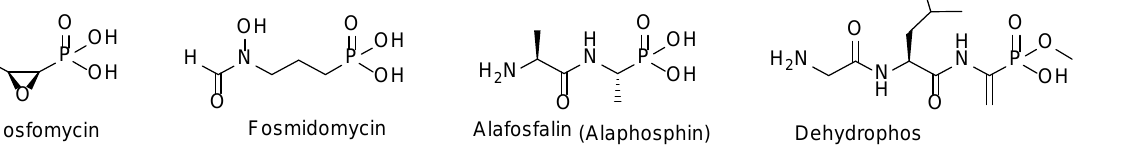
Figure 6. Chemical structures of Fosfomycin, Fosmidomycin, Alaphosphin (Alafosfalin) and Dehy- drophos.